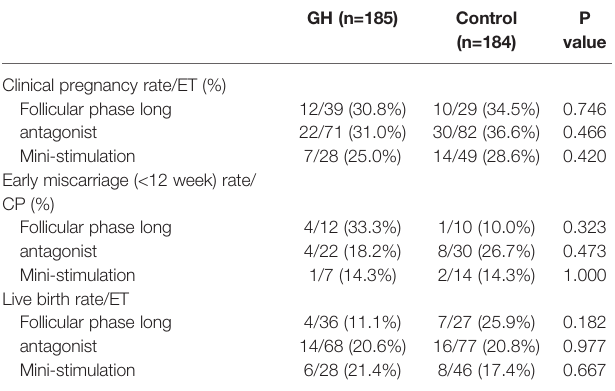
TABLE 6 | Clinicaloutcomesoffrozen-thawedcyclesstrati fi edbystimulationprotocol.